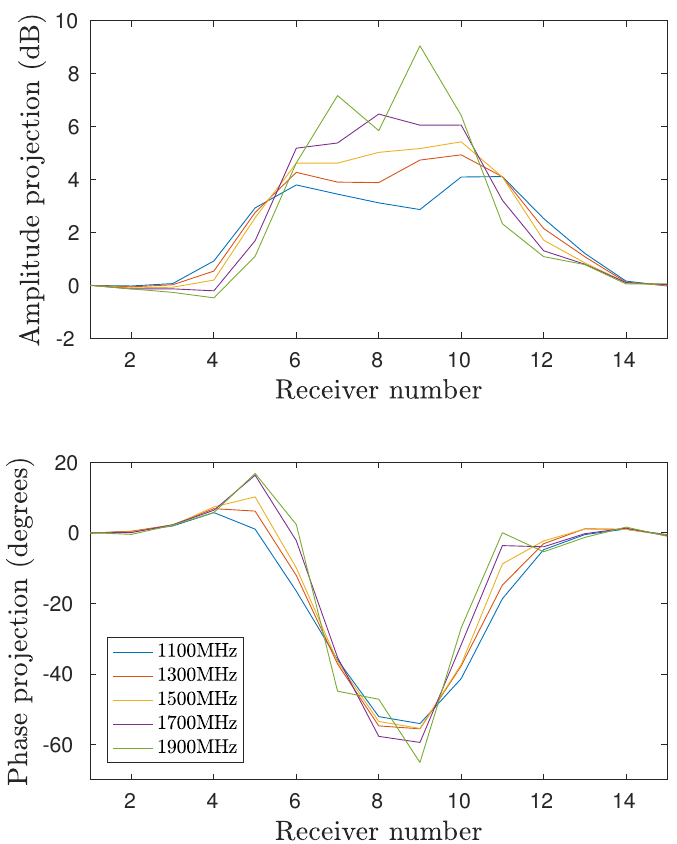
Figure 9. Projection data as function of receiver for the frequencies 1100MHz, 1300MHz, 1500MHz, 1700MHz, and 1900MHz. Antenna 1 is transmitting and the fourth layer is